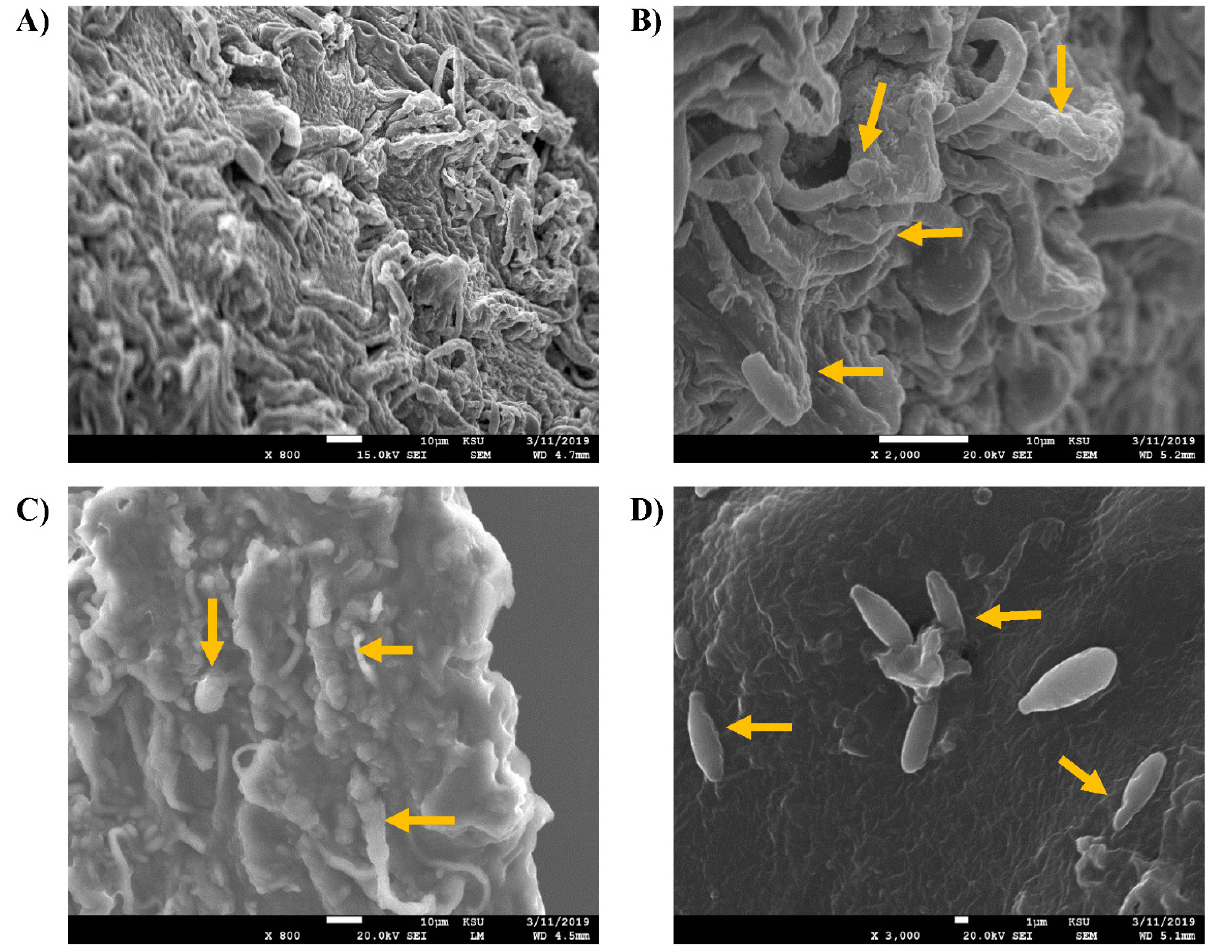
Figure 4. SEM images of F. verticillioides. The tested slides were loaded with F. verticillioides upon treatment with 1% of crude oil. ( A ) (At 800 × , scale bar 10 µ m) normal morphology of the healthy control, ( B ) (At 2000 × , scale bar 10 µ m), ( C ) (At 800 × , scale bar 10 µ m), and ( D ) (At 3000 × , scale bar 1 µ m) showed abnormal configuration of the fungus treated with 1% crude oil, indicated by the yellow arrows, ( B , C ) showing the swelling of edges, ( D ) showed the deformed spores. Although F. proliferatum showed an ability to grow on 1% crude oil, that caused some deformities in its cellular growth. Similar results were obtained for F. proliferatum (Figure 5). The SEM images revealed swelling, blurring, and knots forming on the out ‐ most edges, which decreased the smoothing of the cellular walls. The microconidia struc ‐ tures were not clear or disappeared.